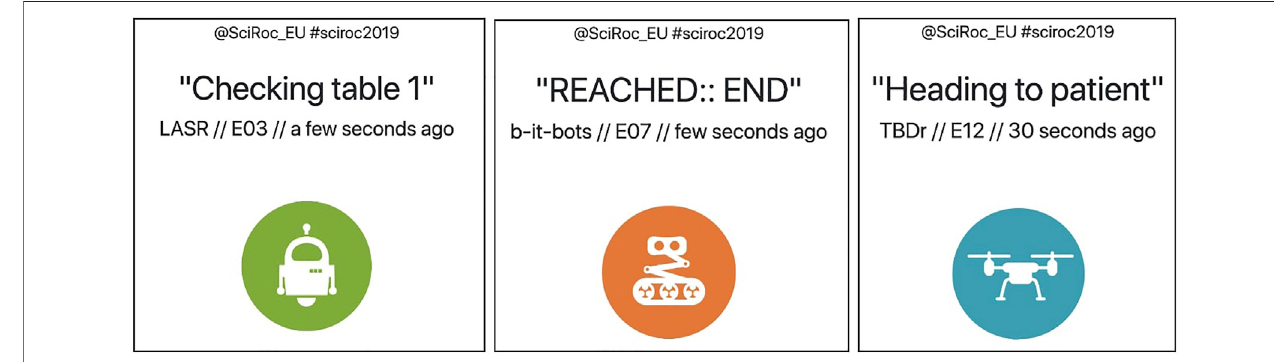
FIGURE 3 | An excerpt of the SciRoc Showcase. This is an aggregate view of the active trials among all challenges. Each box shows the most recent status message sent by a speci fi c team in a speci fi c challenge.